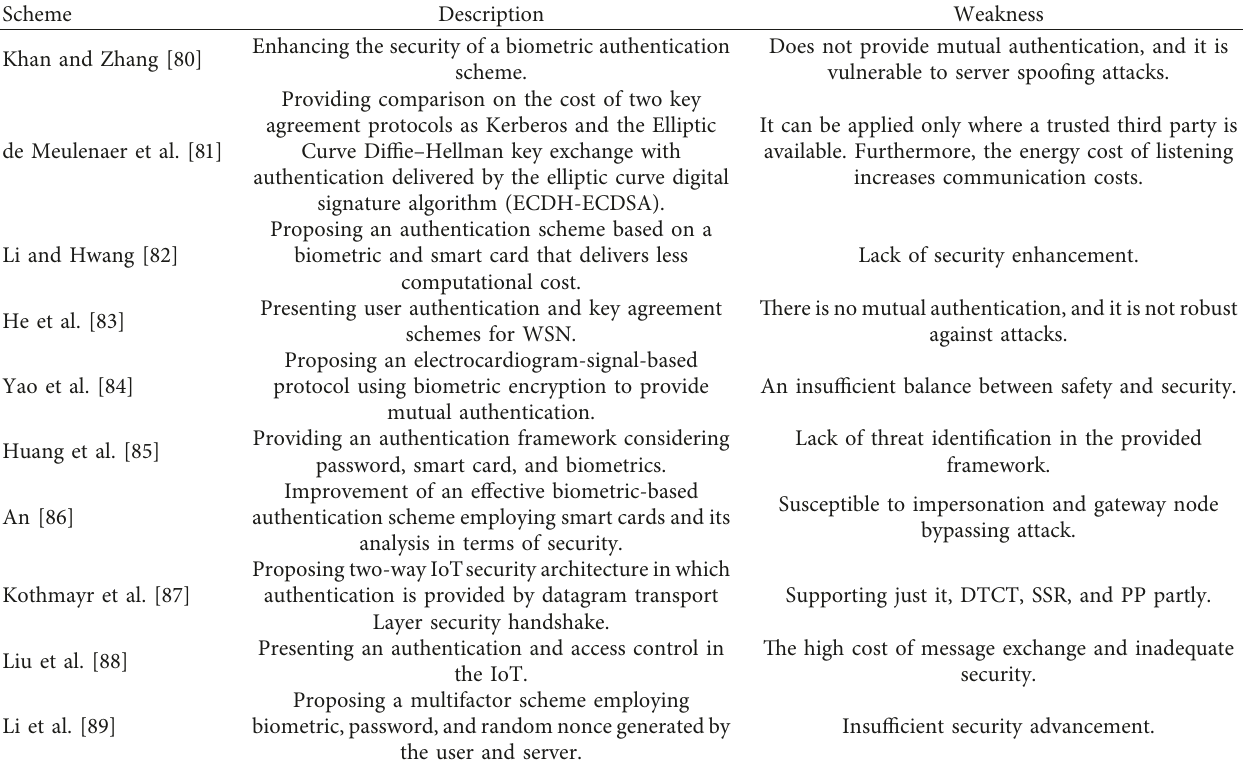
Table 6: Biometrics-based remote user authentication schemes.